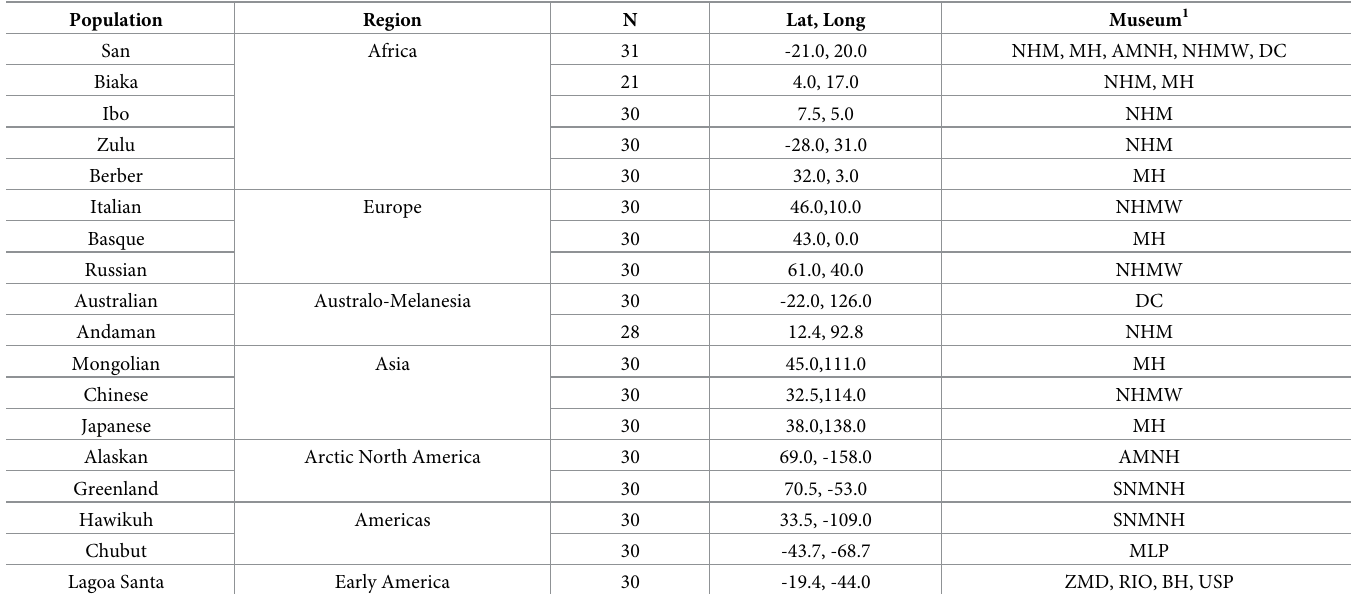
Table 3. Human population craniometric samples used as reference